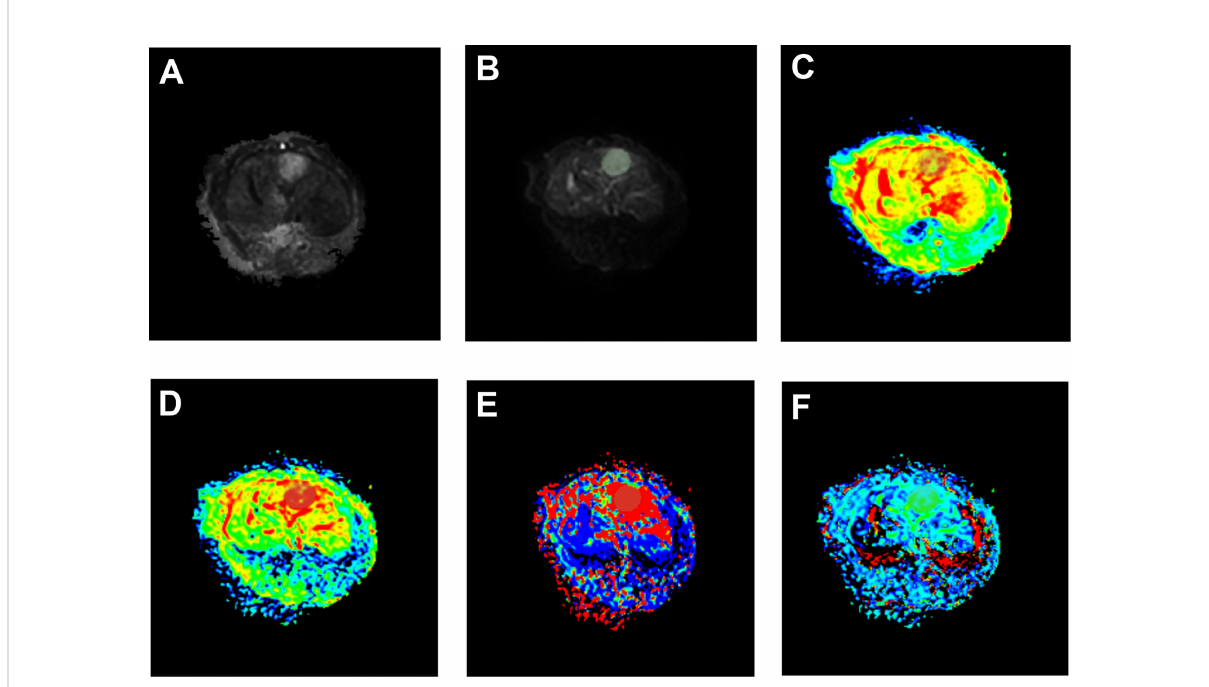
FIGURE 5 Pseudo-color images of IVIM-related parameters 7 days after TAE combined with apatinib treatment. The tumor showed a signi fi cantly high signal on raw DWI images (A) , post-processed DWI images (B) . In pseudo-color images of ADC (C) , pseudo-color images of D (D) , pseudo- color images of D* (E) , and pseudo-color images of f (F) , the grey shaded areas were limited diffusion areas and ROI areas of the